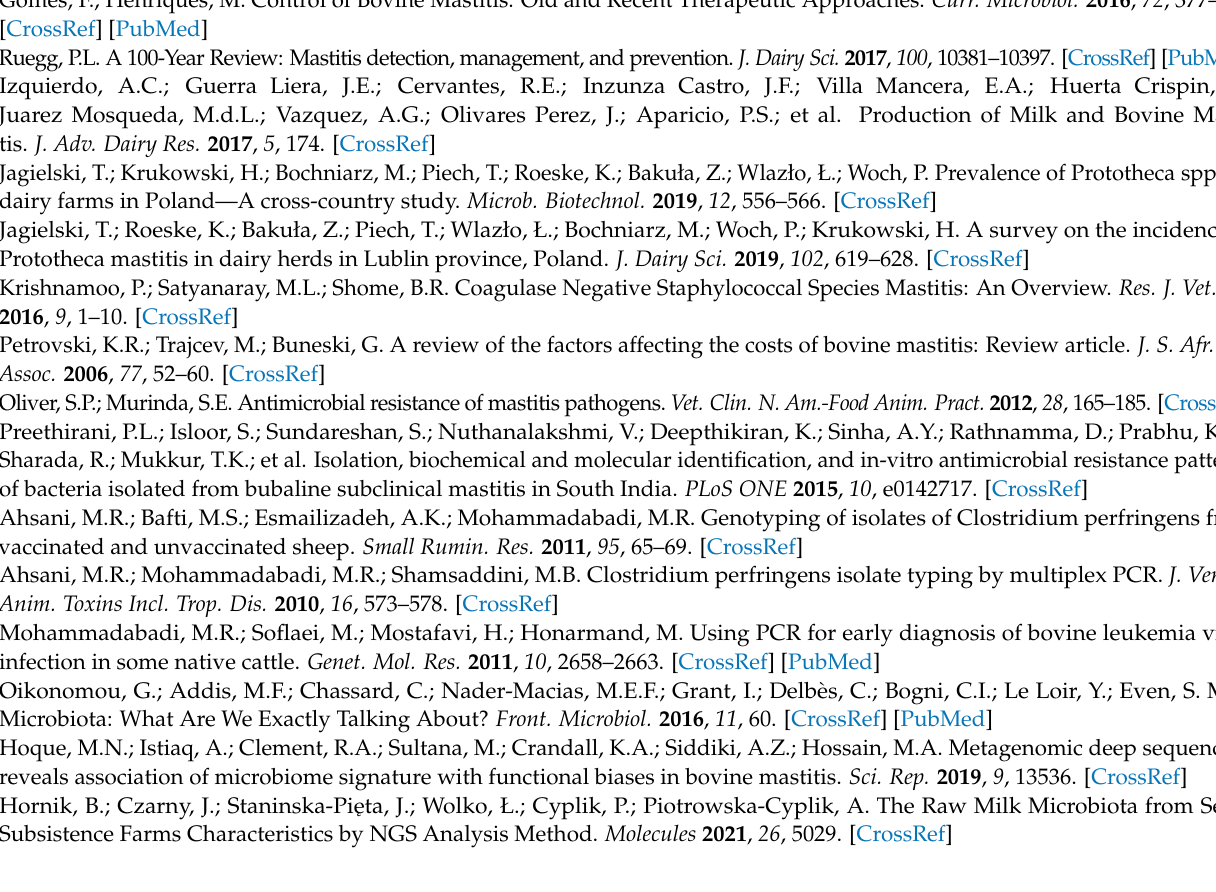
curves for S. agalactiae detection; Figure S2: Construction of the standard curves for E. coli detection; Table S1: The relative abundance of bacterial genera (%) in milk from healthy cows and cows with subclinical mastitis; Table S2: The results of read-filtering in sequencing data analysis; Table S3: Certified standards of bacterial genomes from Vircell and